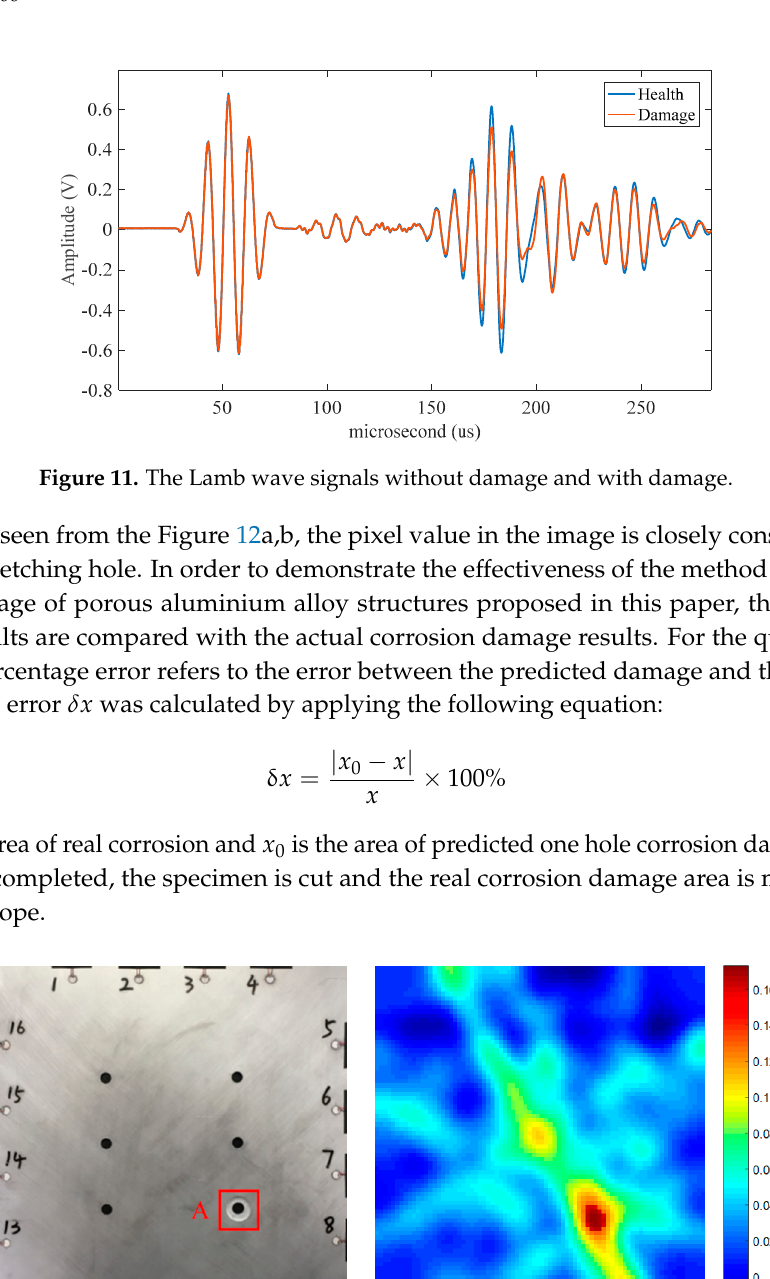
Figure 11. The Lamb wave signals without damage and with damage.